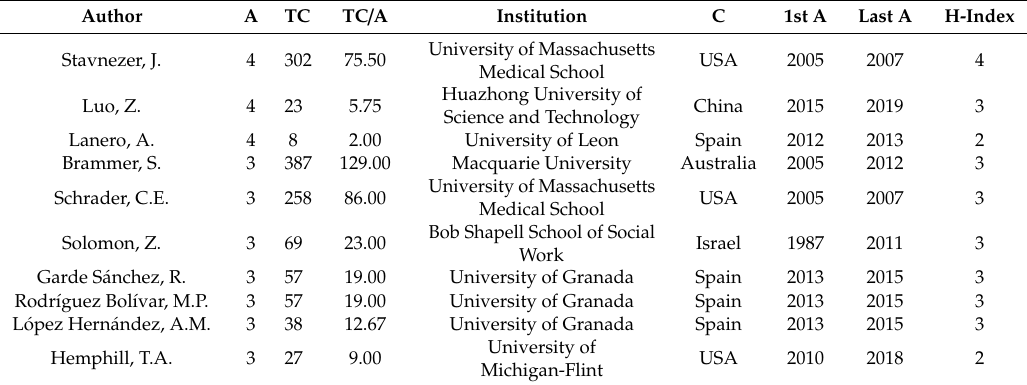
Table 5. The most productive authors in number of articles